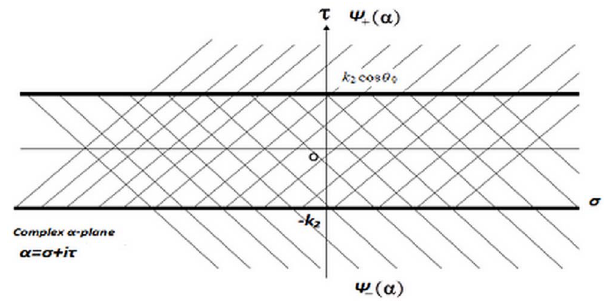
Figure 2. Representation of complex a { plane.